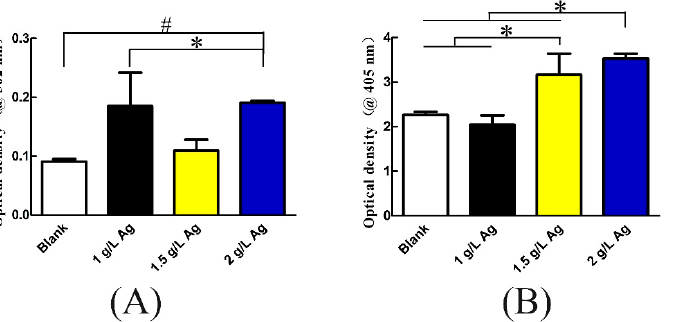
Figure 7. ( A ) Protein adsorptions on the PEO-treated and untreated scaffolds (* p < 0.05; # p <